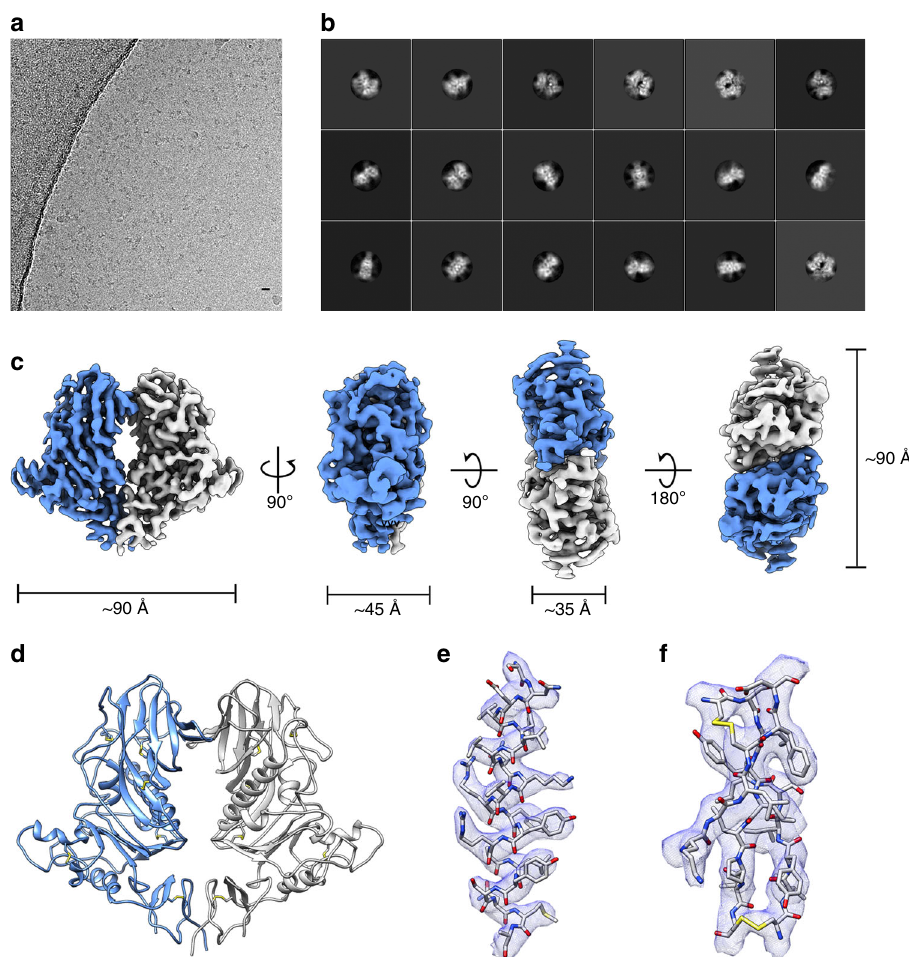
Fig. 1 Structure determination of HKU1 HE by single-particle analysis. a Representative motion-corrected electron micrograph of HKU1 HE embedded in vitreous ice. Scale bar = 10 nm. b Representative reference-free 2D class averages. c Orthogonal views of the HKU1 HE EM density (coloured by subunit). d Cartoon representation of the atomic model of the dimeric HKU1 HE complex. e EM density (blue mesh) zoned 2 Å around an α -helix comprising residues 112 – 132. f EM density (blue mesh) zoned 2 Å around a β -sheet comprising residues 181 – 188, 219 – 224 and 243 –